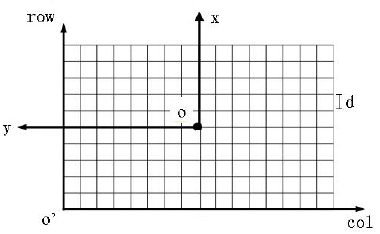
Figure 2. The image plane coordinate system and pixel coordinate system